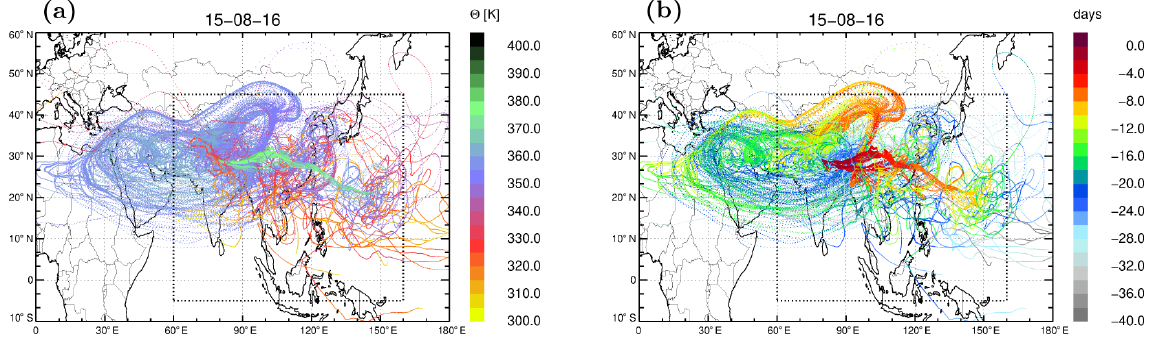
Figure 8. As Fig. 5 but for the balloon flight on 15 August 2016 (Case 2). In addition to Case 1 shown in Fig. 5, the impact of tropical cyclone activity in the western Pacific is found in Case